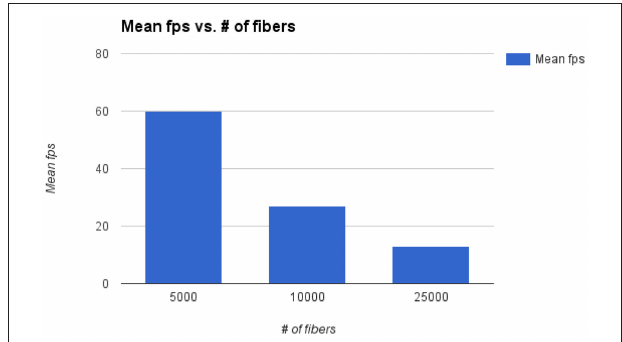
FIGURE 6 | Mean framerate [in frames per second (fps)] vs. number of